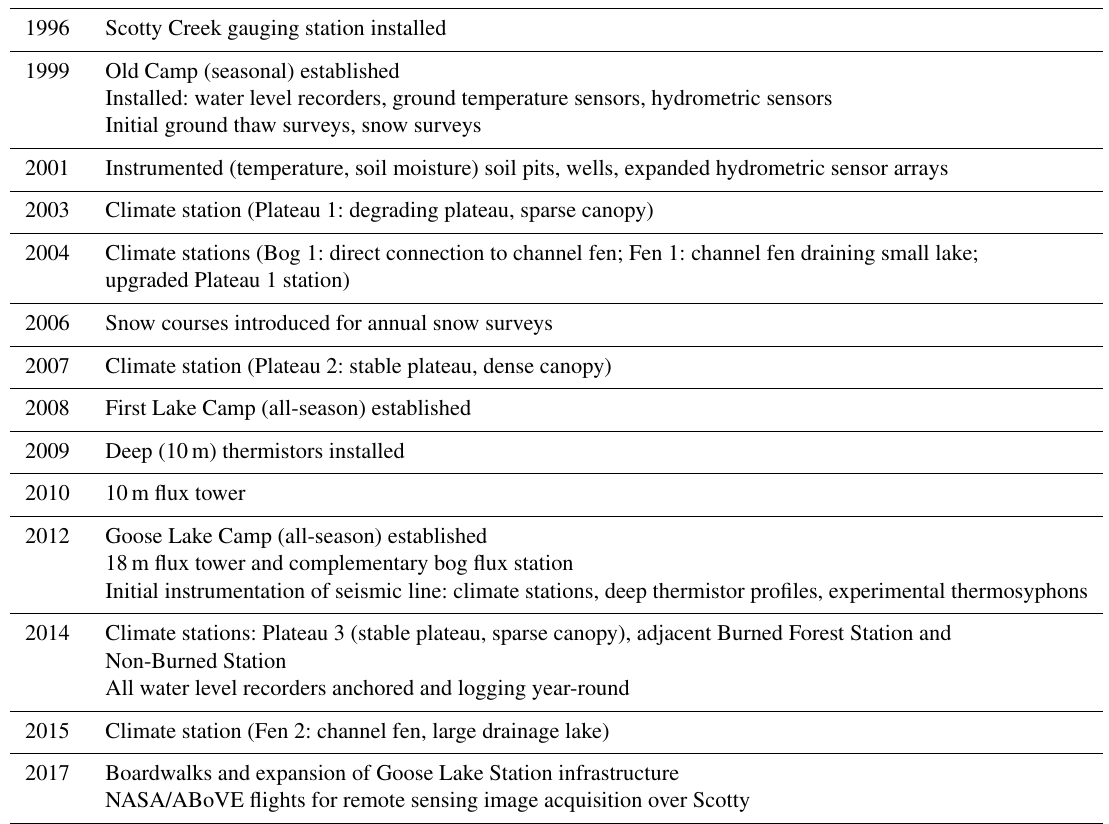
Table 1. Instrumentation at the Scotty Creek research site. A map showing the locations of scientific and other infrastructure at the Scotty Creek Research Station is available at http://www.scottycreek.com/ (last access: 1 April 2019). This online map is regularly